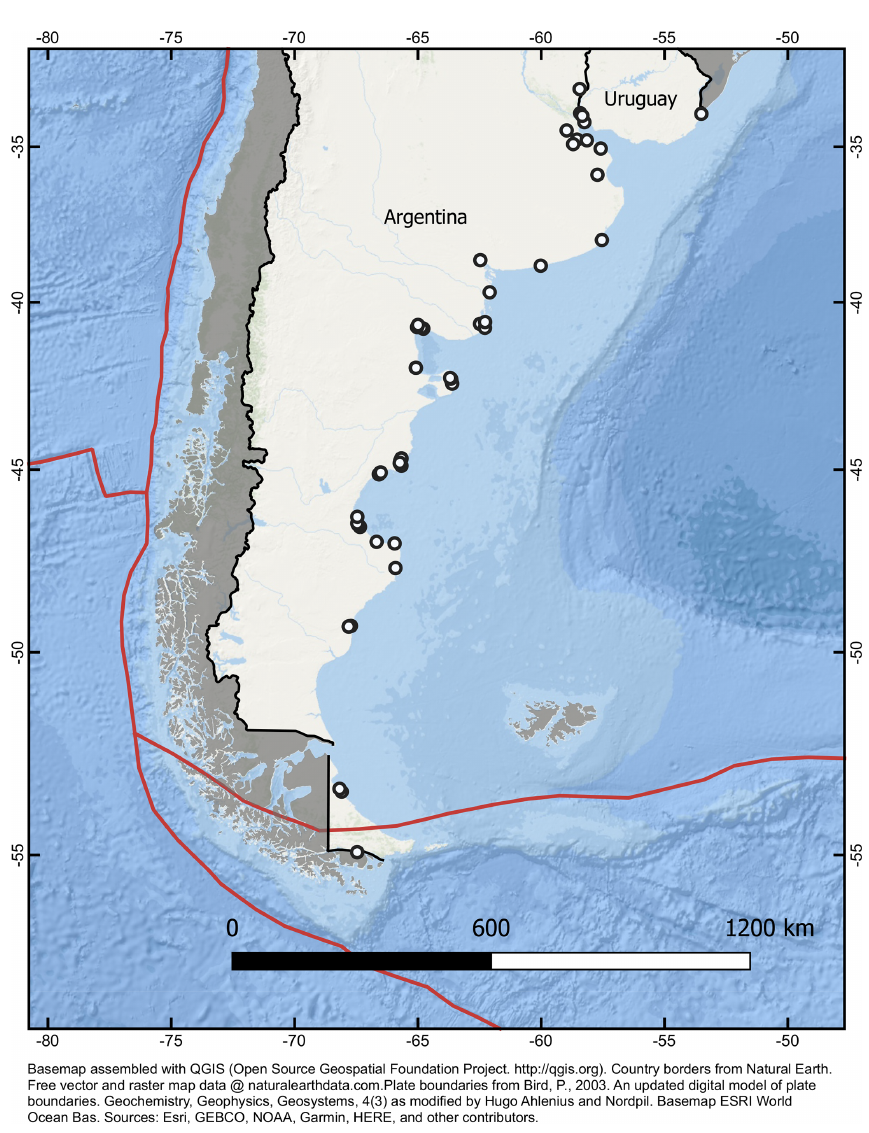
Figure 2. MIS 5 sea-level indicators along the southeastern South America coastline (black-outlined circles).